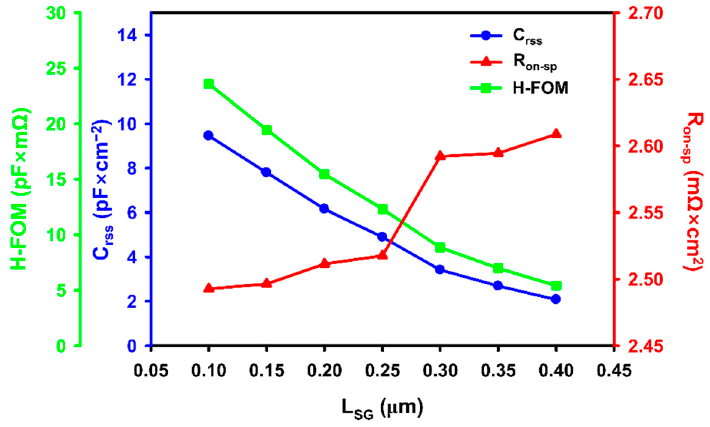
Figure 2. Comparisons of the specific on-resistance (R on-sp ), gate-drain capacitance (C rss ), and H-FOM characteristics for different L SG of DTMCD-MOSFET.